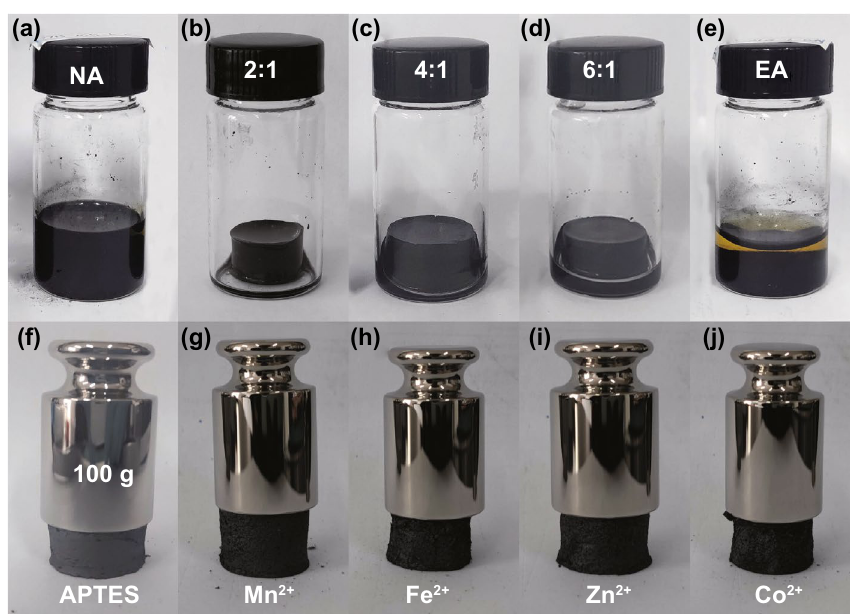
Fig. 2 Room temperature assembly of Ti 3 C 2 T x . a Ti 3 C 2 T x /RGO mixture without adding interfacial mediators. b – d Ti 3 C 2 T x /RGO hydrogels obtained from different